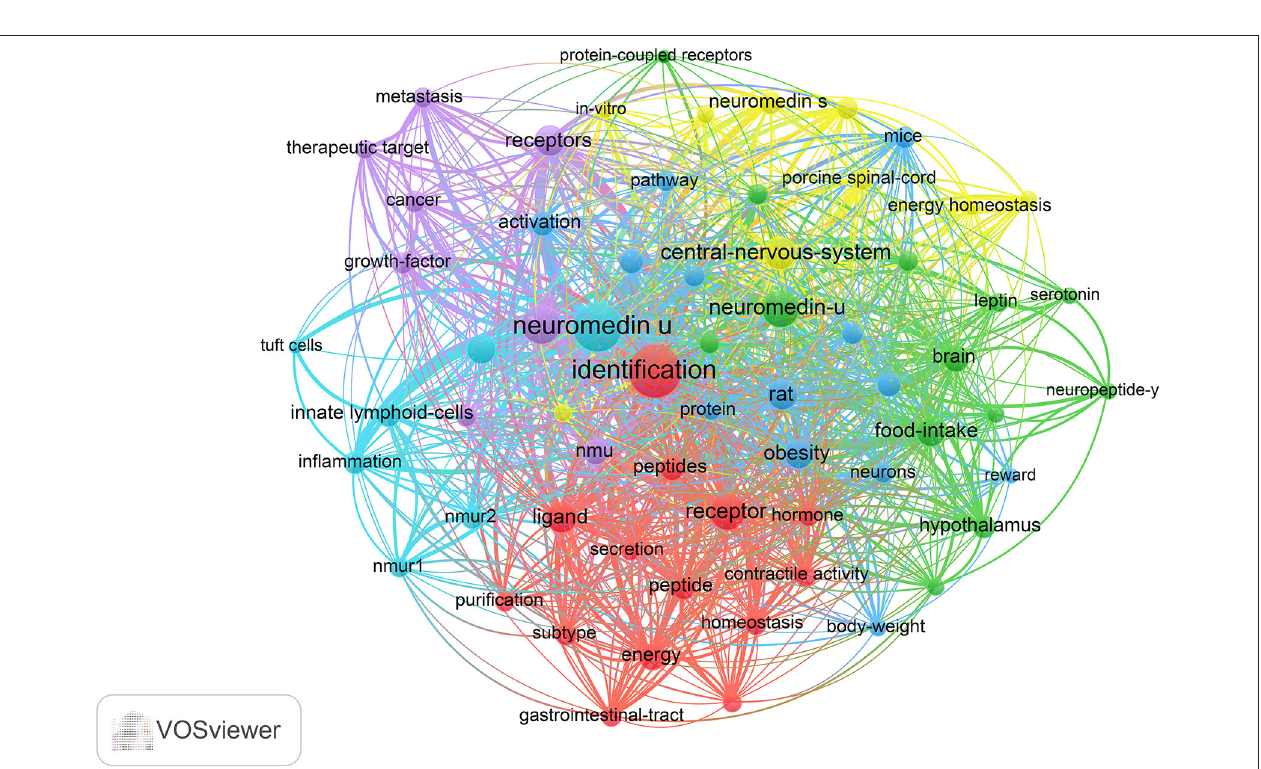
FIGURE 6 | The analysis of keywords in NMU research. The keywords were classified into six clusters and were depicted in different colors (“central-nervous system,” in yellow; “homeostasis,” in red; “energy metabolism,” in blue; “cancer,” in purple; “immune-inflammatory,” in fluorescent blue, and “food intake,” in green).